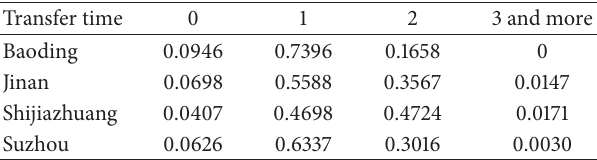
Table 2: The proportion of transfer times of the four